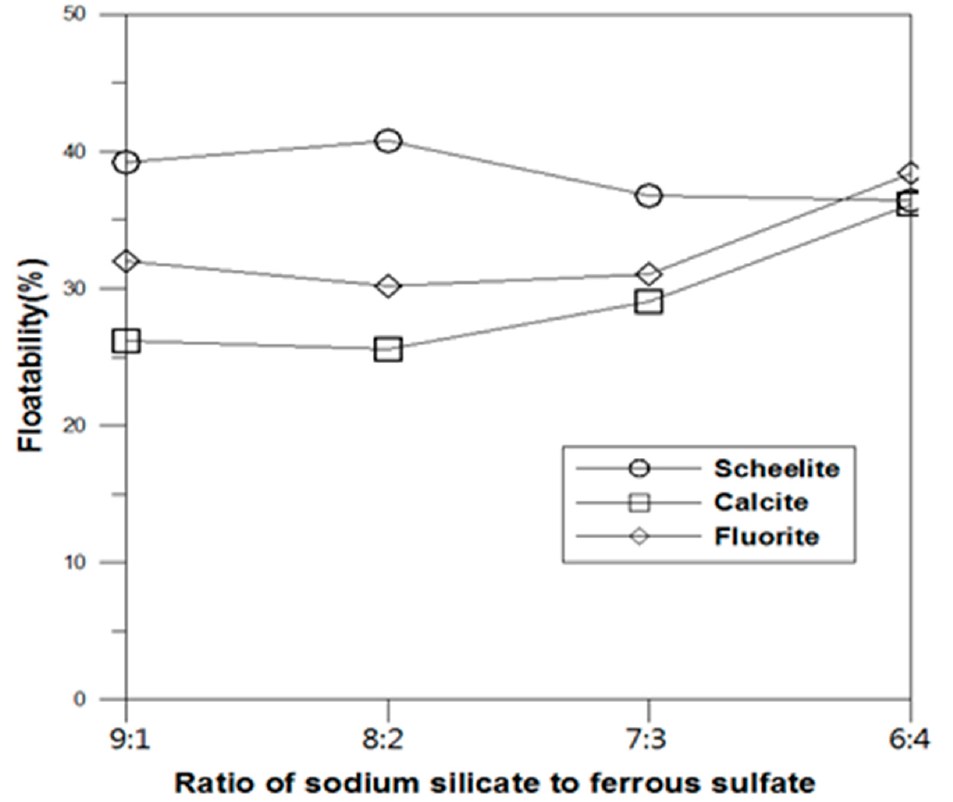
Figure 3. Floatability of scheelite, calcite, and fluorite in the function of the mixing ratio of sodium silicate and ferrous sulfate from 6:4 to 9:1.